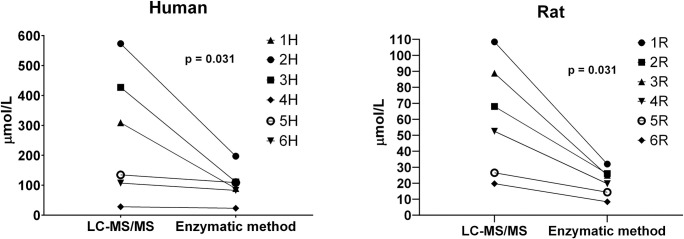
Enzymatic method underestimates total BA concentration in cholestatic serum samples with atypical BA spectra.Concentrations of total BAs in six cholestatic human sera and six cholestatic rat sera were determined using an enzymatic kit (triplicates) and LC-MS/MS (single measurement).